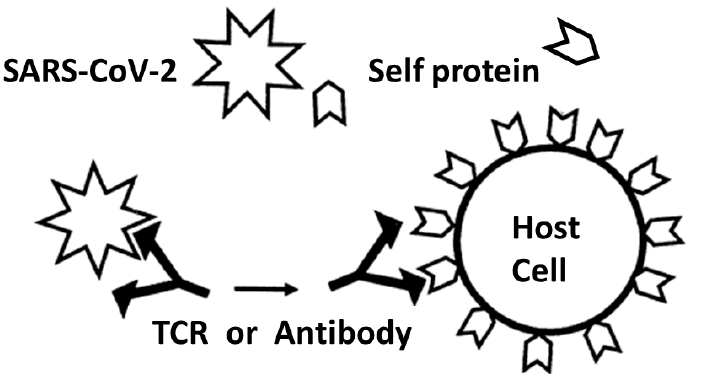
Figure 10. Schematic diagram of the molecular mimicry theory of autoimmune disease induction. A virus, such as SARS-CoV-2, mimics a self-protein on a host cell. The immune system responds by activating T or B cells that express T cell receptors (TCR) and/or antibodies (shown here for simplicity) that are complementary to the viral antigens. Because of the mimicry between the viral antigens and the self-protein, some of the resulting TCRs and/or antibodies may target host cells expressing these self-proteins, resulting in autoimmune disease [109–112]. While this theory is based on the sort of mimicry observed in expanded TCRs from COVID-19 patients, it actually predicts that the resulting TCR sequences should be complementary to SARS-CoV-2, not similar. Additionally, this theory makes no predictions that would explain TCR mimicry of the select set of bacteria that are found as co-infections in COVID-19.